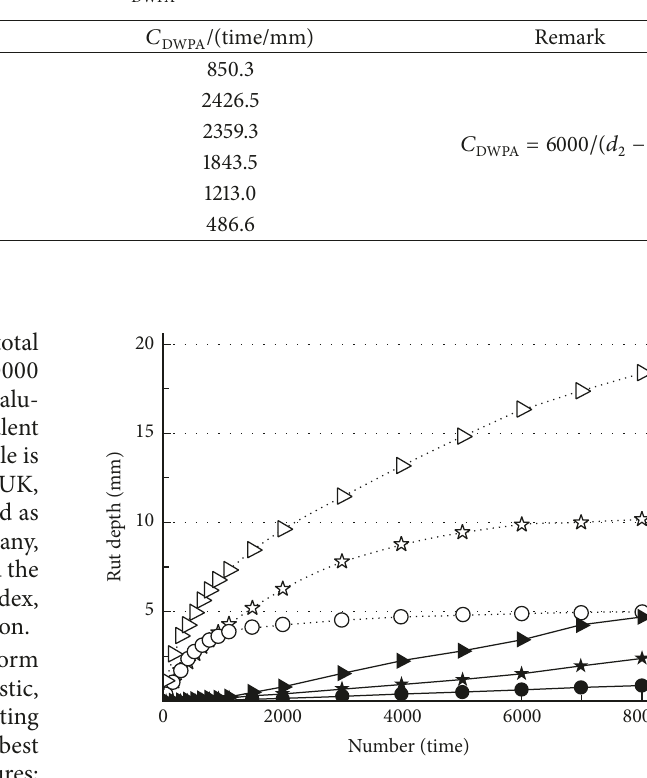
Table 4: Results of 𝐶 DWPA .